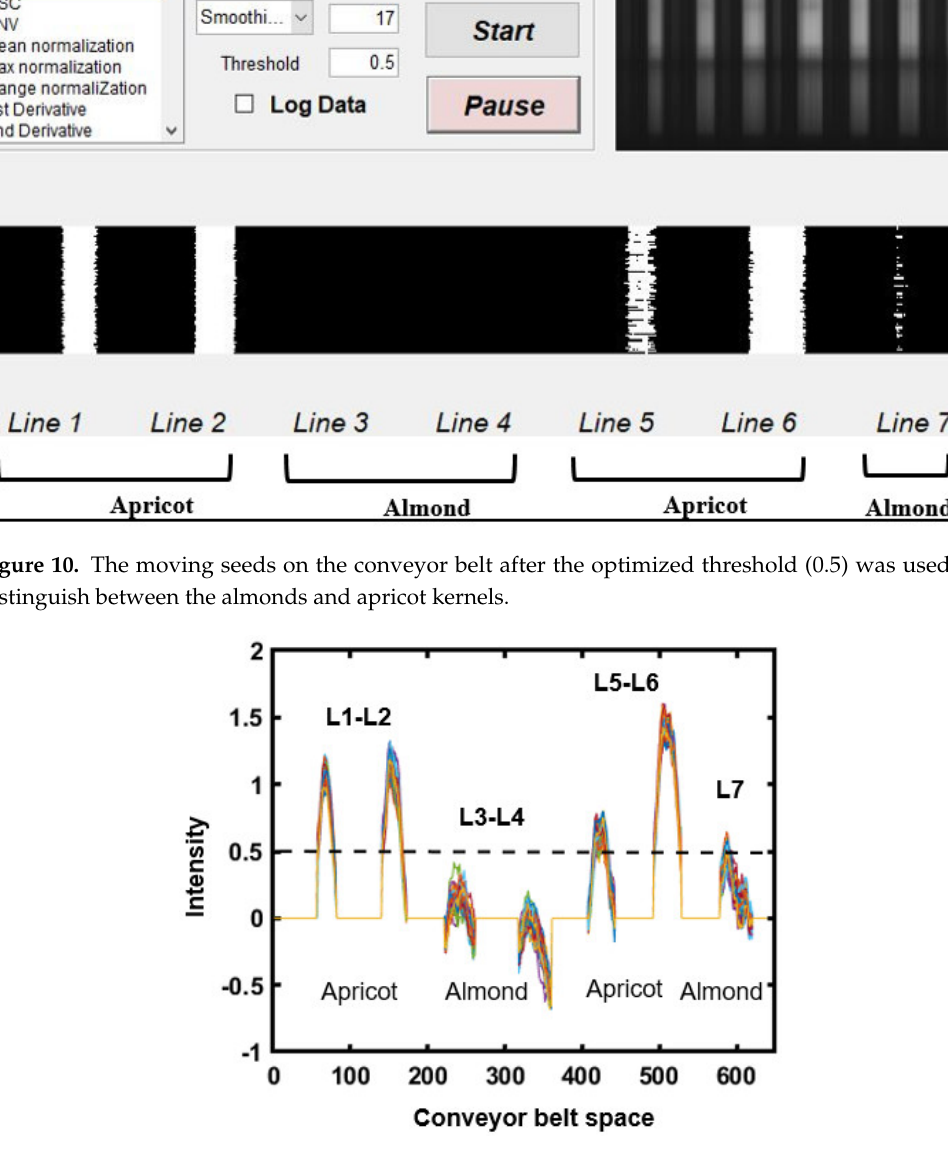
Figure 10. The determination of the threshold point for seed discrimination in lines. Figure 11. The determination of the threshold point for seed discrimination in